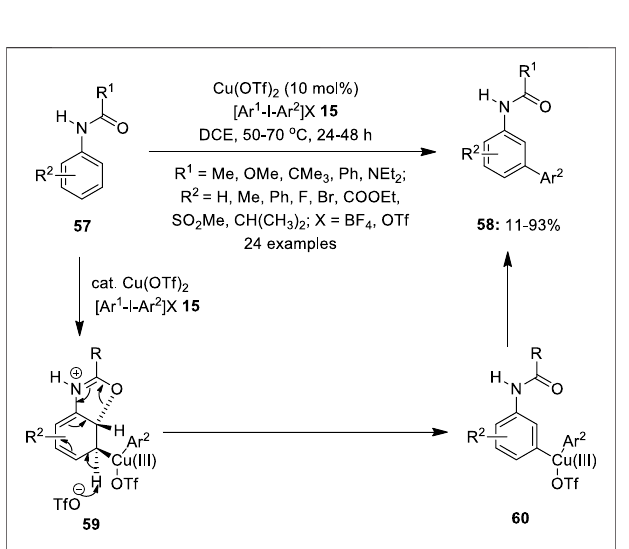
Frontiers in Chemistry |